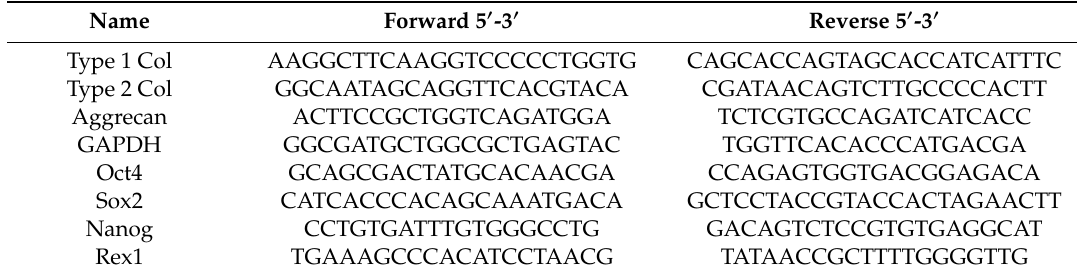
Table 1. Primer sequences used for real-time PCR